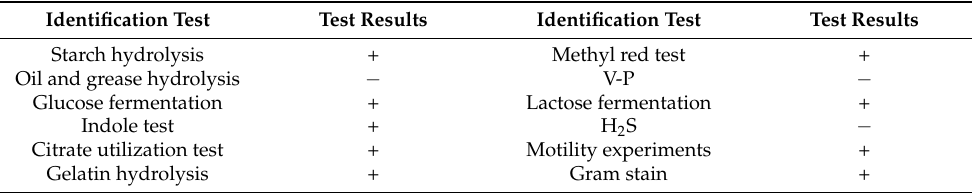
Table 2. Physiological and biochemical characteristics of the LBA119 strain.